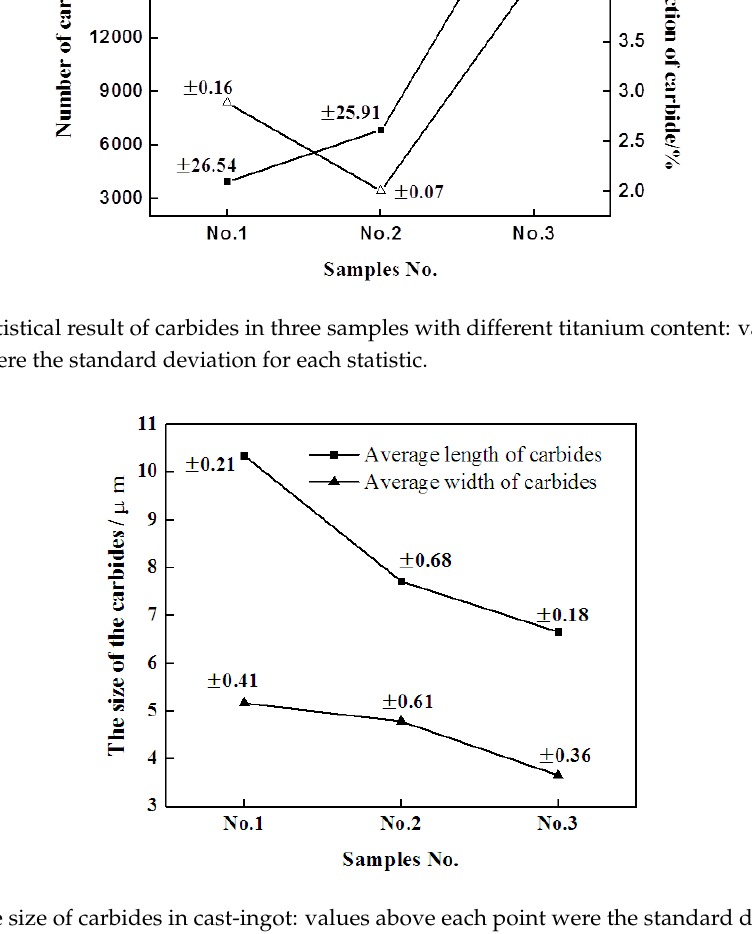
Figure 5. The size of carbides in cast ‐ ingot: values above each point were the standard deviation for each statistic.